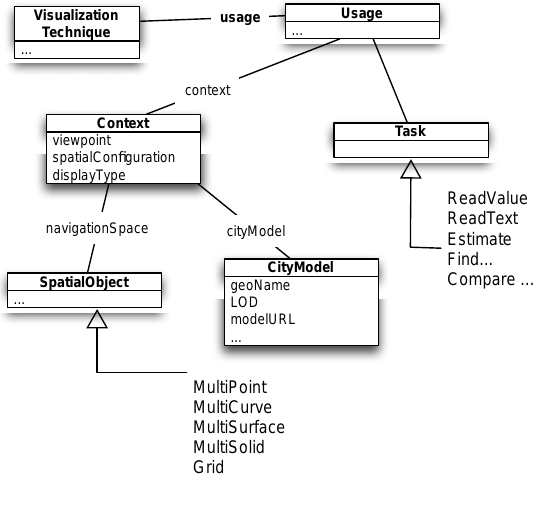
Figure 6. Usage representation